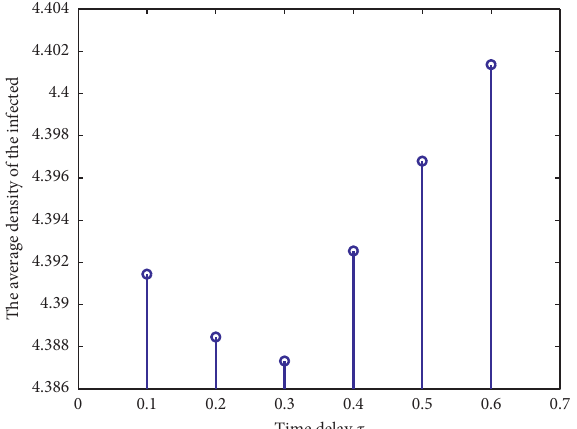
Figure 5: The relationship between the average density of the infected and time delay τ